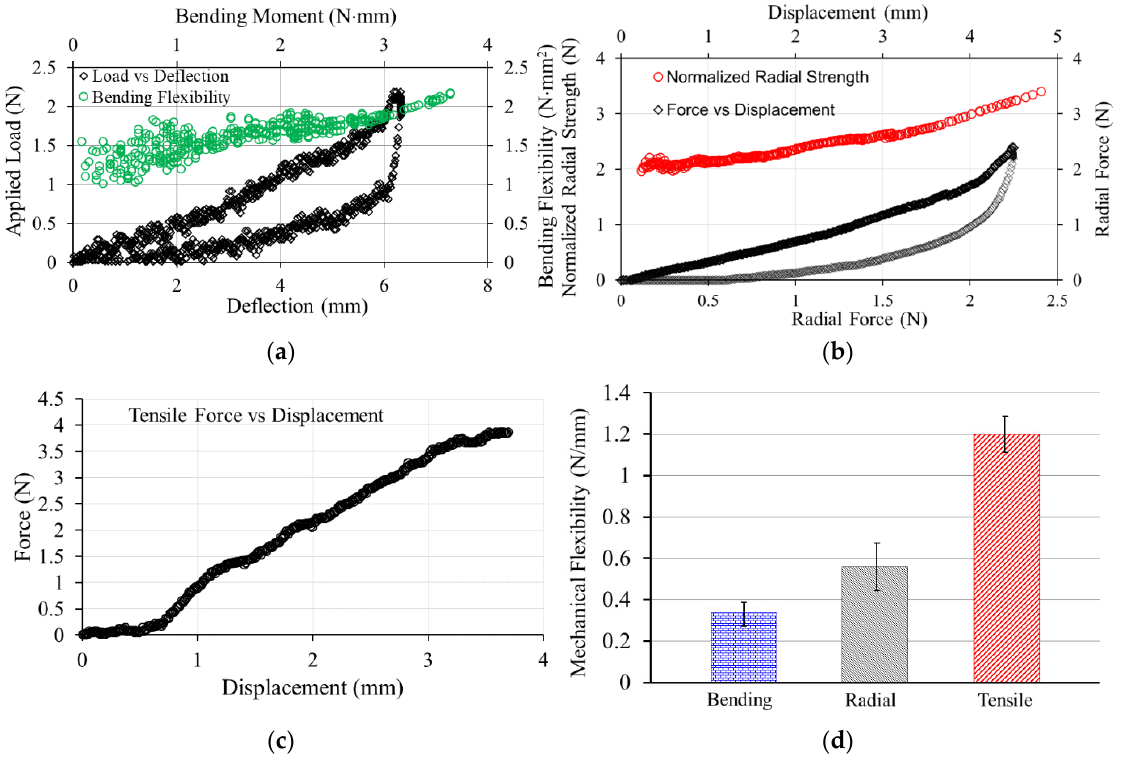
Figure 3. Mechanical strength and flexibility analysis of a Polycaprolactone (PCL) flow diverting stent (FDS): ( a ) three- point bending test; ( b ) flat plate radial compression test; ( c ) tensile force—displacement in longitudinal tension test and ( d ) average FDS flexibility in bending, radial and tensile experiment of FDS with ±1 standard deviation error bar.